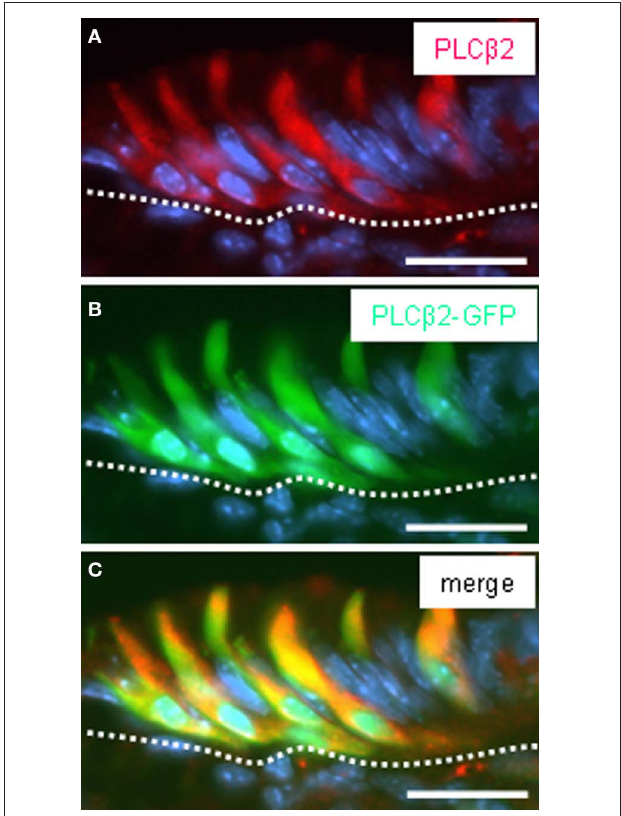
FIGURE 3 | Pattern of GFP fluorescence in transgenic PLC β 2 promoter-GFP mice correlates with endogenous PLC β 2 expression in cells of the corpus mucosa adjacent to the fundus compartment. (A–C) Analysis of cross sections through the fundus/corpustransition zone of PLC β 2 promoter-GFP transgenic mice. PLC β 2-immunostaining (red) (A) reveals a cluster of elongated cells located in the most apical layer of the corpus mucosa (denoted by the white dotted line ) adjoining the fundus epithelium. Intrinsically green fluorescent cells (B) are located in the same regions within the mucosa and display the morphology of cells visualized by the PLC β 2 antibody. Overlay (C) of (A) and (B) clearly demonstrates the coexpression of PLC β 2 and GFP in a subset of cells. The cells exhibit very long apical processes extending into the lumen of the “gastric groove.” Sections were counterstained with DAPI ( blue ). Scale bars: (A–C) = 20 μ